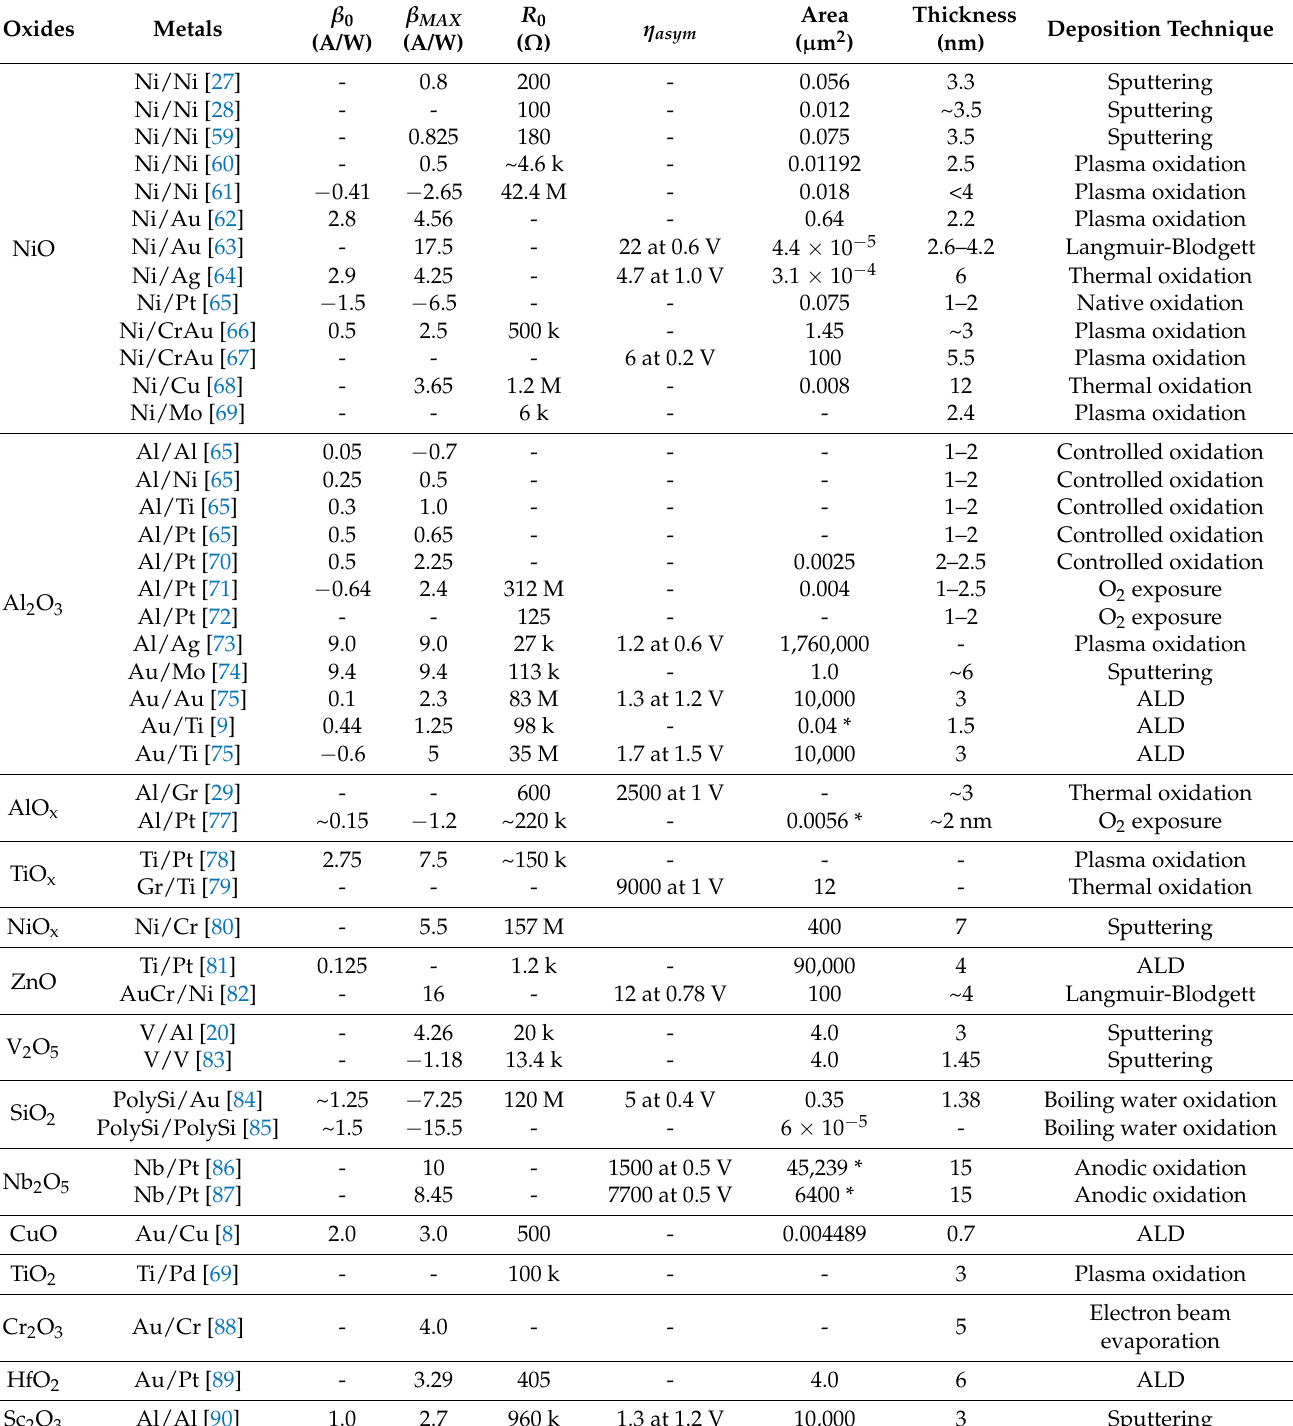
Table 2. A summary of rectification parameters for state-of-the-art MIM diodes, including the device area, oxide thickness and deposition